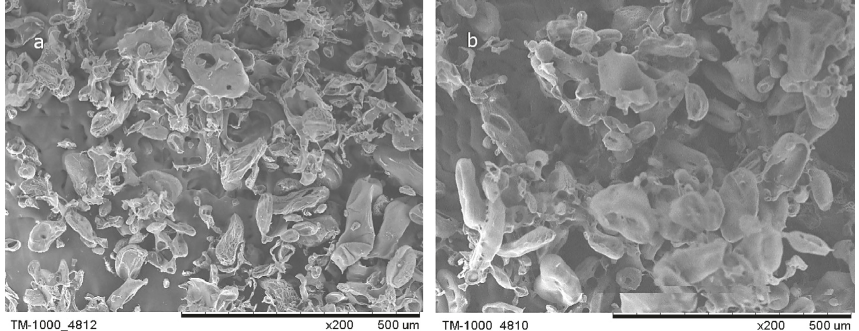
Figure 7: SEM images for CMS/CS hydrogel at different ratios: (a) 320 and (b)